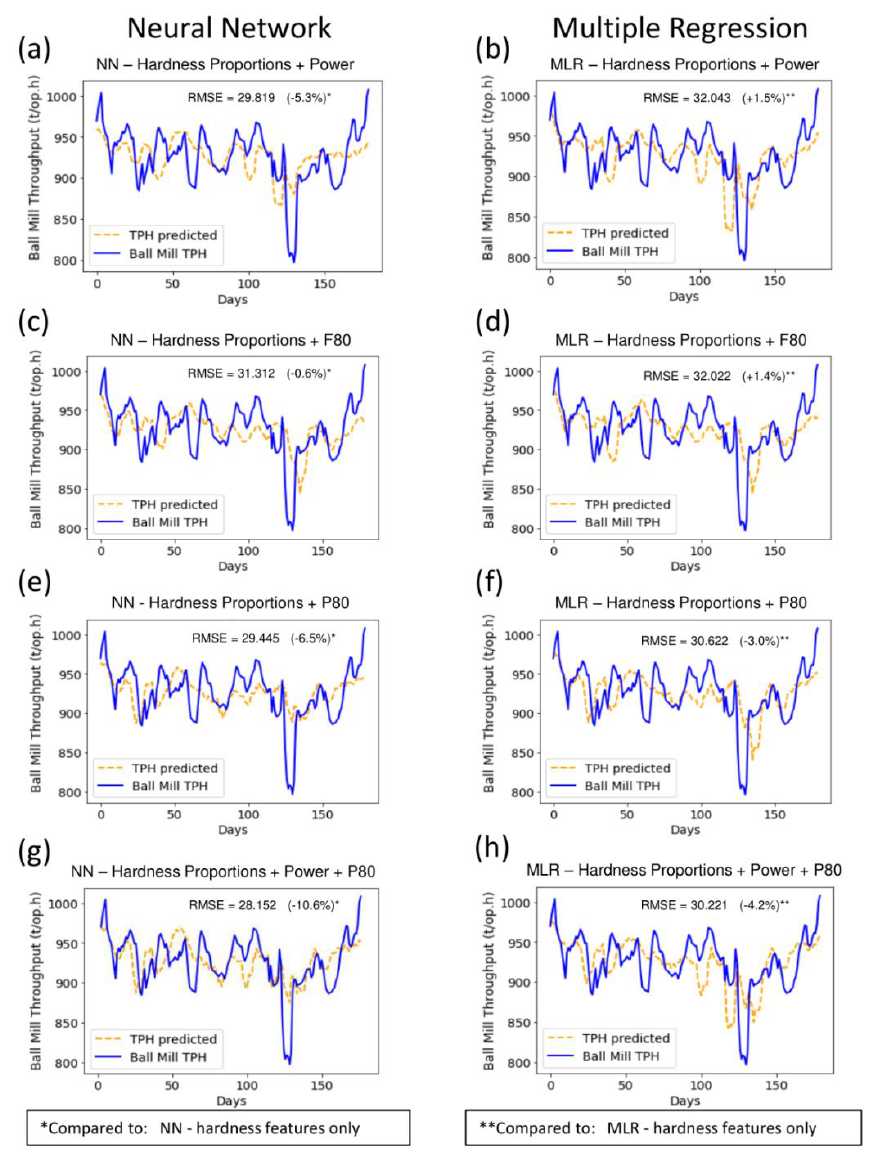
Figure 8. Ball mill throughput prediction (20-fold cross-validation) using as additional features: ( a ) ball mill power (NN), ( b ) ball mill power (MLR), ( c ) feed particle sizes (NN), ( d ) feed particle sizes (MLR) ( e ) product particle sizes (NN), ( f ) product particle sizes (MLR) ( g ) power and P80 (NN), ( h ) power and P80 (MLR) – RSME is compared in brackets to respective model predictions (neural network/multiple regression) using hardness features only.